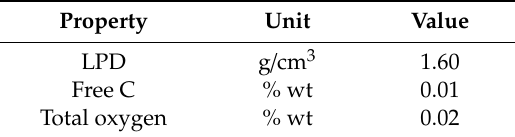
Figure 1. Particle size distribution of the SiC powder source SIKA High Purity SiC. Table 1. Summary of measured powder